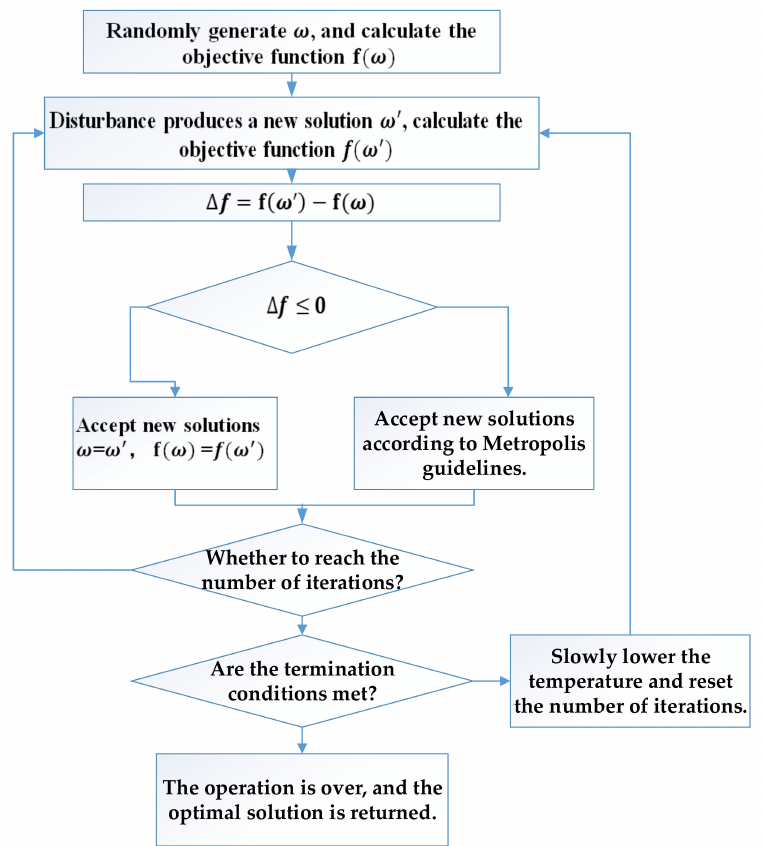
Figure 6. Process of simulated